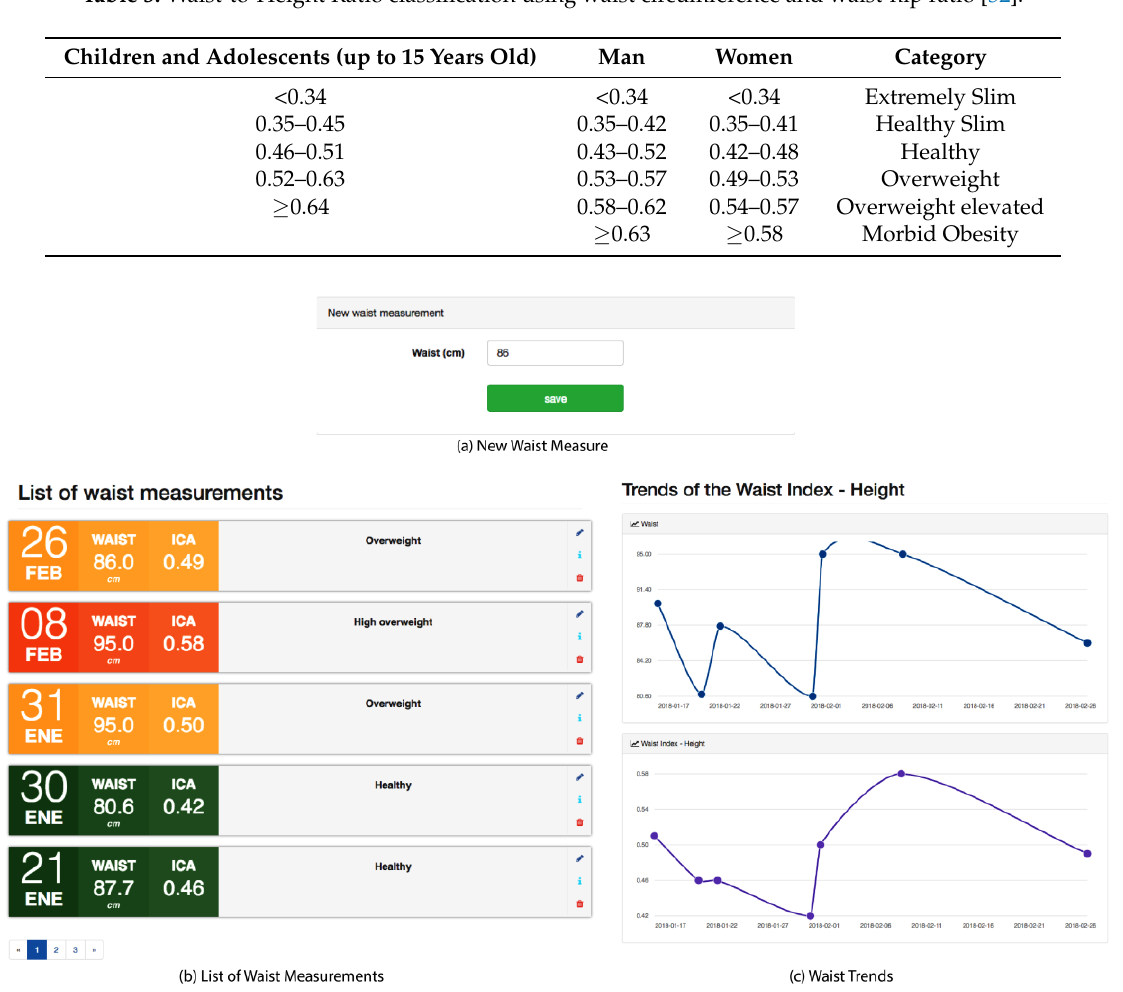
Figure 8. Waist-to-Height Ratio module.